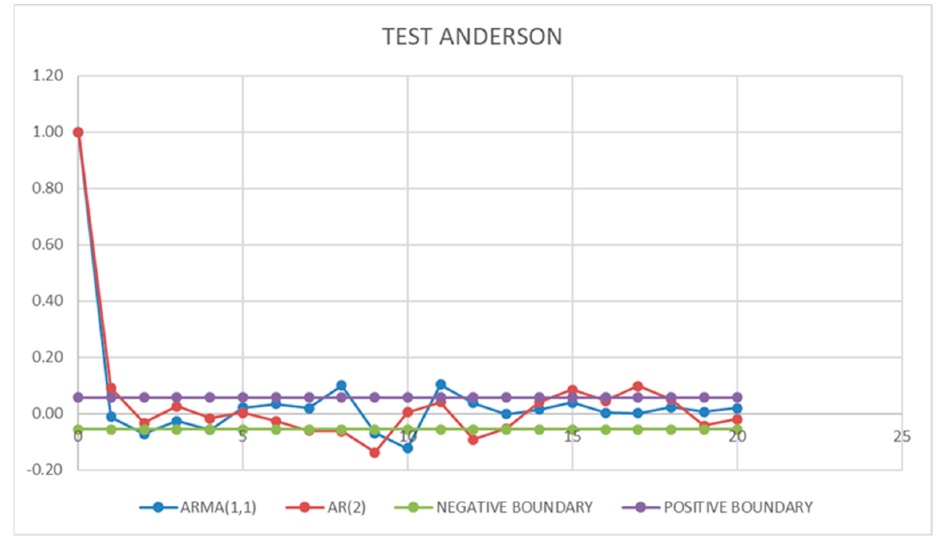
Figure 2. Anderson test for the rainfall time series.